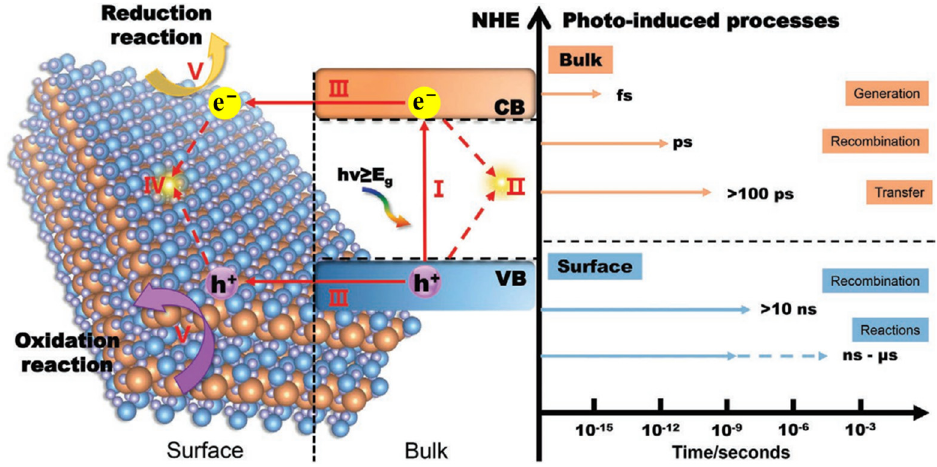
Figure 5. Different steps and time scales in the photocatalytic reaction based on semiconductor catalysts [89].